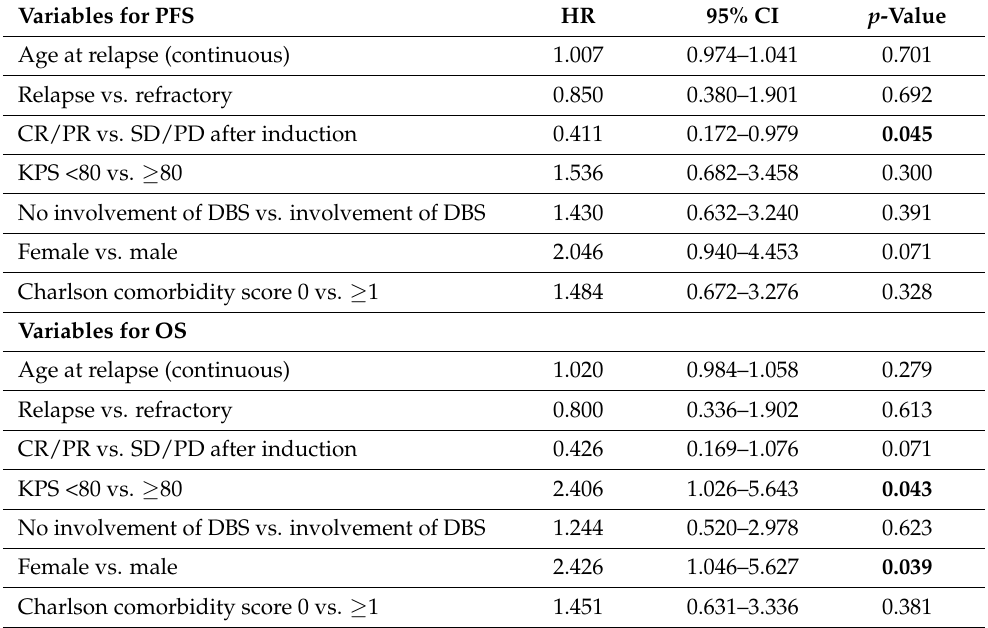
Table 2. Multivariate analysis of prognostic factors for progression free survival and overall survival ( n = 50 patients who completed HCT-ASCT).